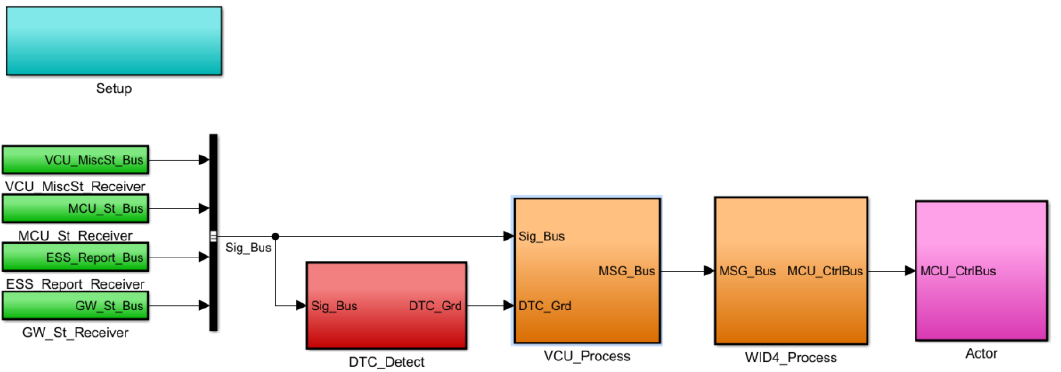
Figure 13. Simulink Model of Controller.